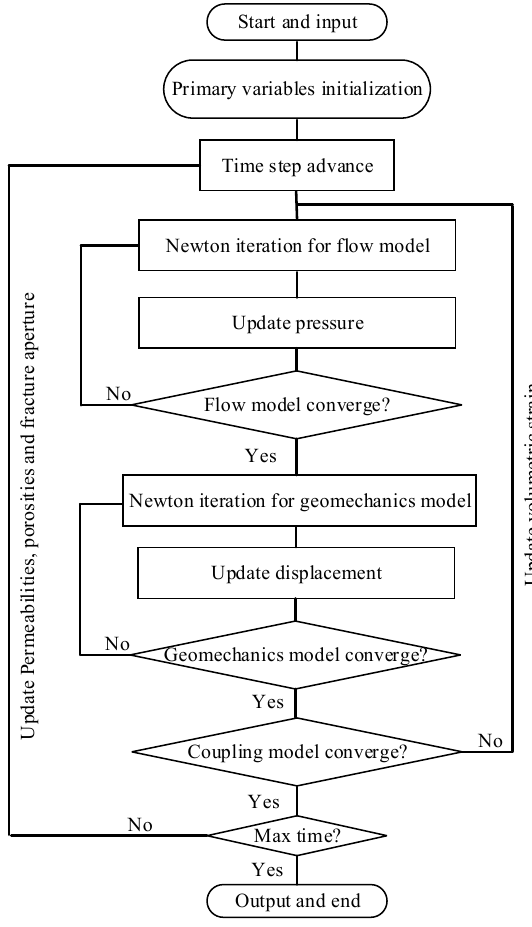
Figure 3. Schematic of the fixed stress sequential implicit method.